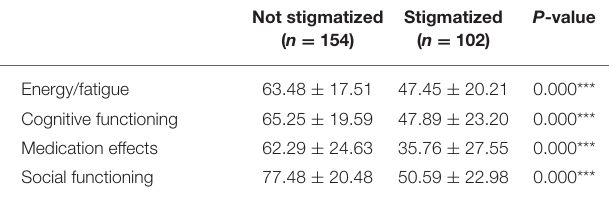
TABLE 3 | Relations between felt stigma and clinical characteristics.